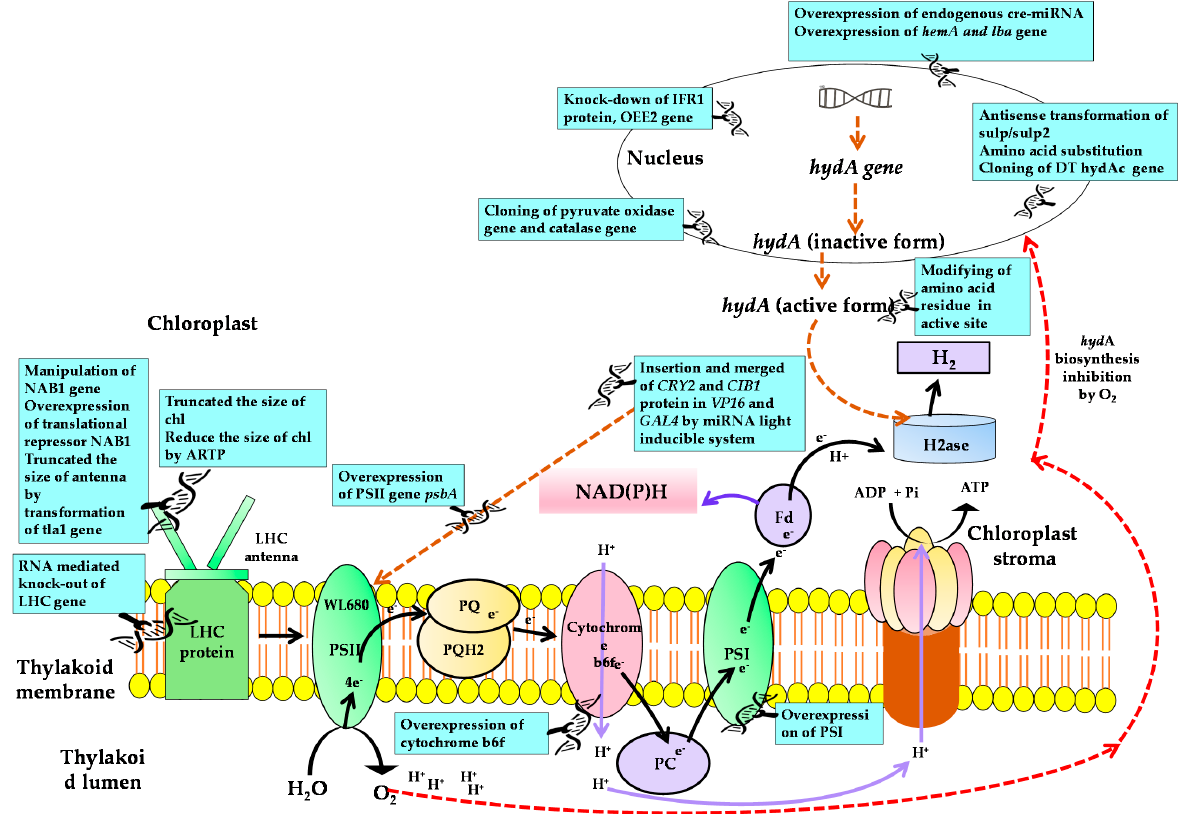
Figure 5. Different genetic approaches used for bioH 2 production. Reproduced from [3], Elsevier B.V.: 2021.